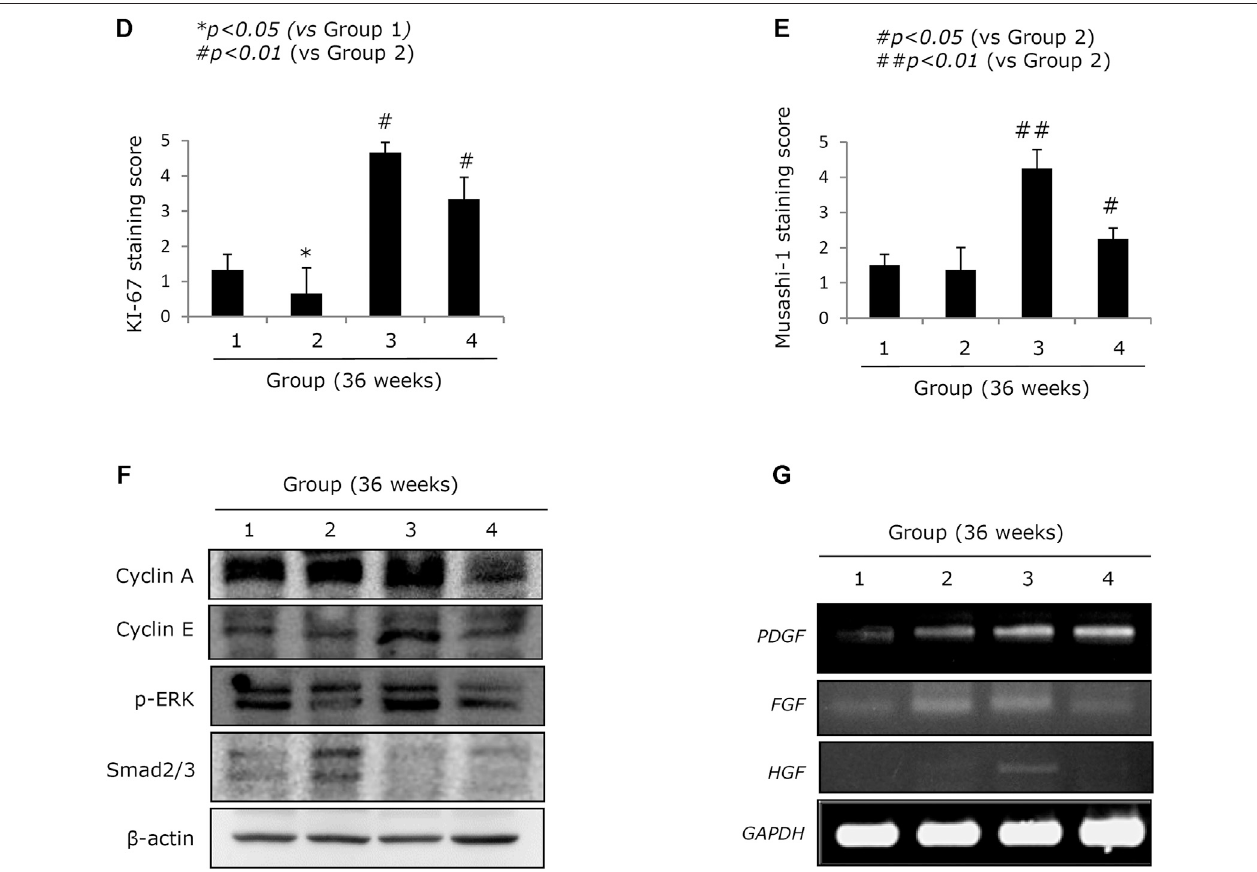
FIGURE 2 | Changes of stemness according to groups relevant to gastric atrophy. (A) Scores for gastric atrophy: left, representational pathology of Group 2 showing signi fi cant changes of CAG featured with a loss of parietal cells, gastric in fl ammation, and a loss of gastric glands with some foci of erosions; right, scores according to groups. See Supplementary Table 2 for the scoring system. (B) Immunohistochemical staining of the proton pump with antibody of H + /K + -ATPase. (C) Confocal staining with LGR5+ antibody: left, representational staining with LGR5+, x100 magni fi cation; right, mean scoring according to groups. (D) Immunohistochemical staining of Ki-67 antibody and the mean positive scoring according to groups. (E) Immunohistochemical staining of Musashi-1 antibody and the mean positive scoring according to groups. (F) Western blot for cell cycle, ERK among MAPK, and smad2/3. (G) RT-PCR for PDGF , FGF , and HGF mRNA. All data represent mean ± SD ( n (cid:1)